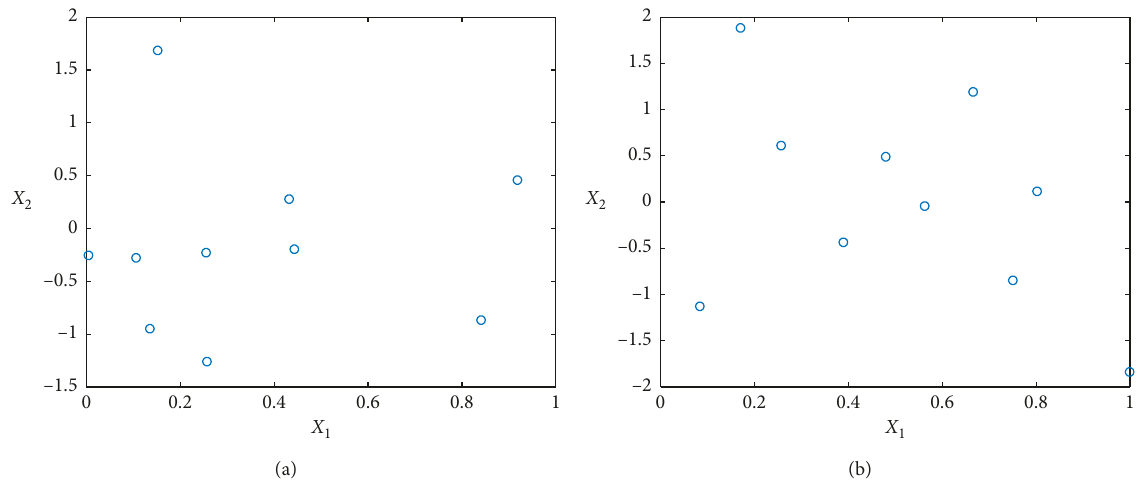
Figure 1: Examples of two methods to generate a sample of size n distribution u